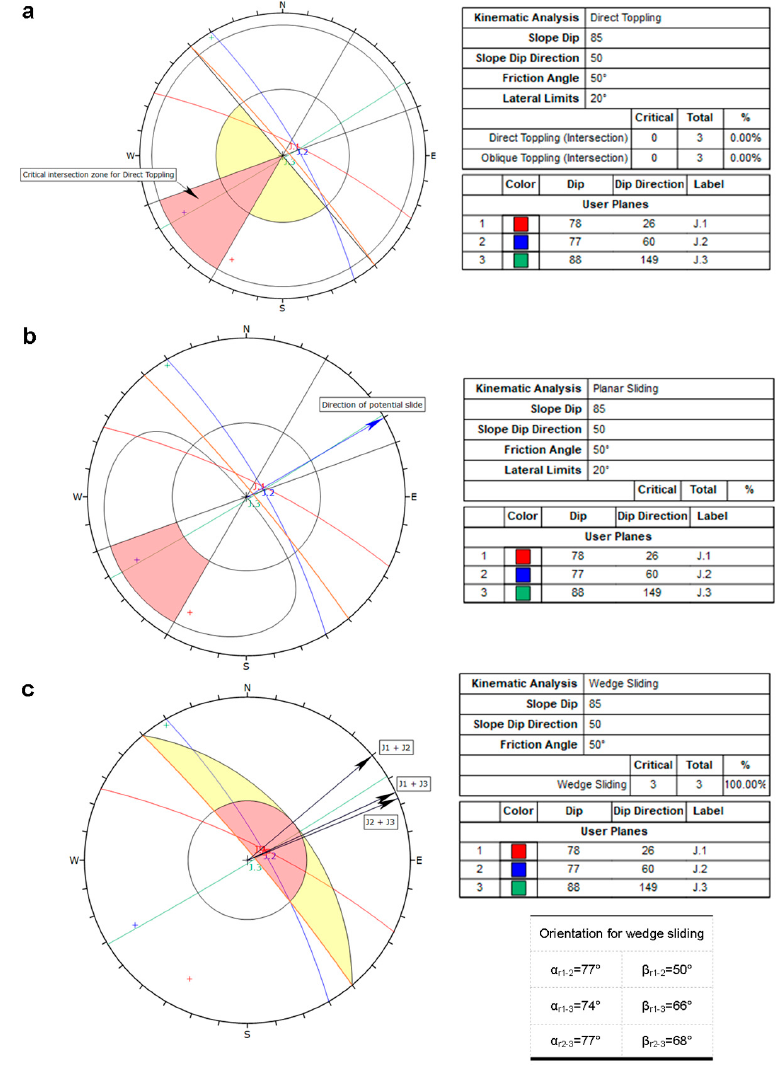
Figure 12. Kinematic analysis for different failure criteria: ( a ) direct toppling; ( b ) planar sliding; ( c ) wedge sliding.